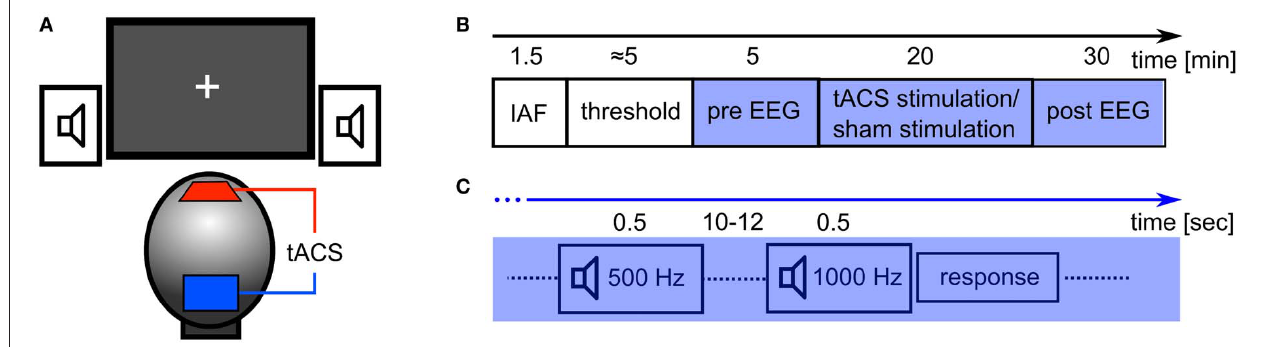
perform a detection task with either closed (Experiment 1) or open eyes (Experiment 2). In the first 5min of this period, the EEG was recorded ( pre EEG) and served as a baseline. Subsequently, 20min of stimulation (tACS or sham) were applied. Afterwards, the EEG was recorded for 30min ( post EEG). (C) Detection task: every 10–12s, a tone was presented for 500ms. 80% of those were standards (500Hz) and 20% were targets (1000Hz). Subjects had to respond with a button press to each presentation of the target